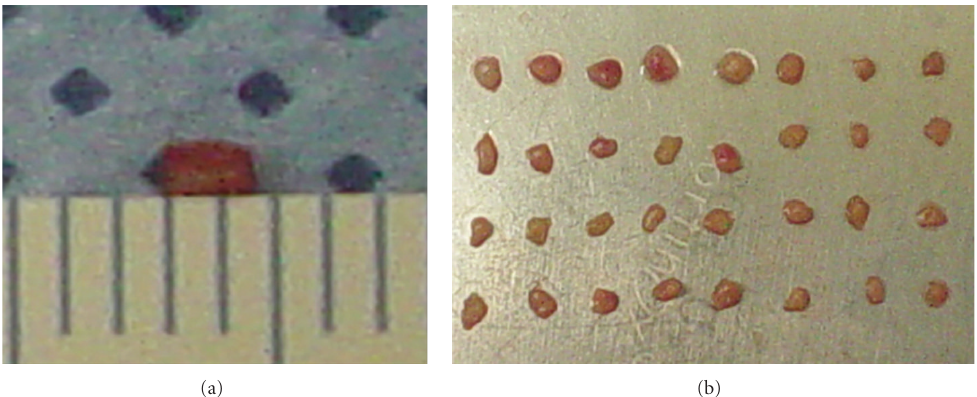
Figure 1: Parathyroid gland fragments sized 2 mm 3 selected for presternal autotransplantation.